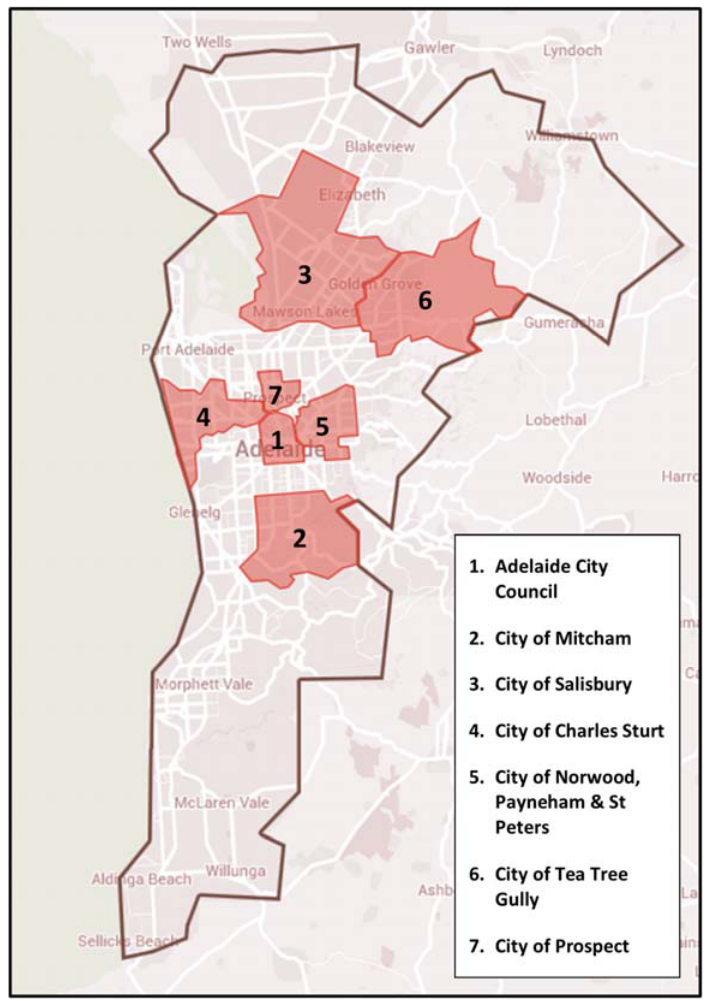
Figure 1. The seven selected Local Government Areas of Metropolitan Adelaide.